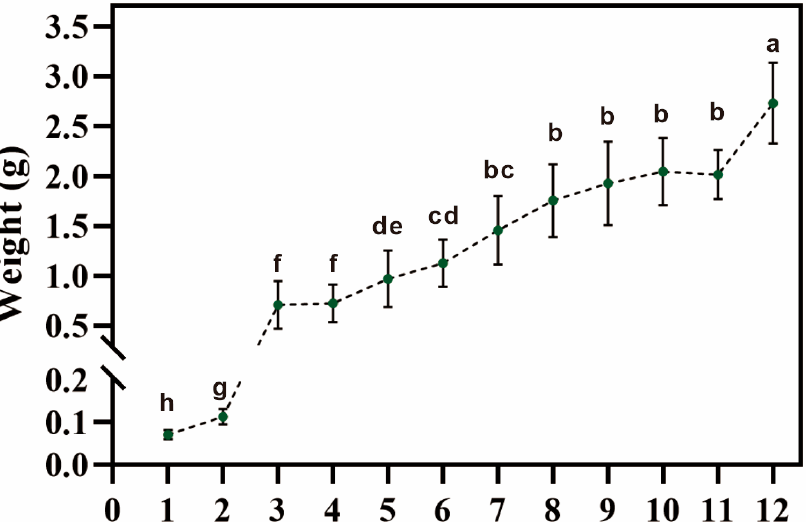
Figure 1. Root biomass at different development stages. Dry weights of each root at different developmental stages. More than 30 samples were measured at each time point ( n ≥ 30). Numbers 1–12 on the x-axis represent the 12 time points, which were 20 May, 5 June, 20 July, 20 August, 5 September, 20 September, 5 October, 20 October, 5 November, and 20 November. Different letters above the bars indicate a significant difference ( p < 0.05) by one-way ANOVA with Tukey’s post-hoc test.